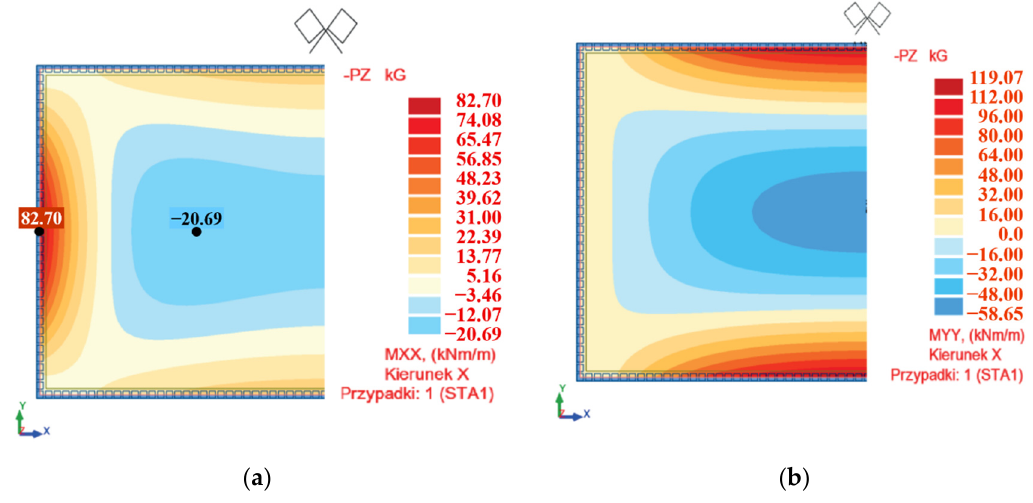
Figure 13. Bending moments in the reservoir structure [77]: ( a ) in the XX plane; ( b ) in the YY plane.